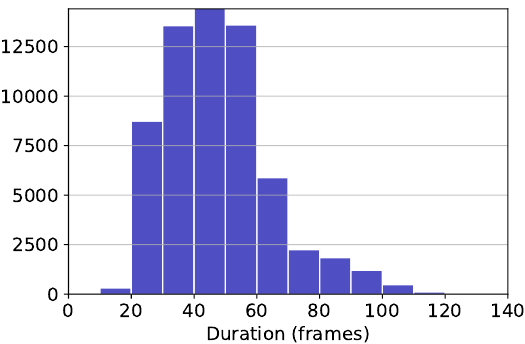
Figure 5. Distribution of syllable duration in Isarn speech corpus. Table 6. Objective results of the training of the proposed model with different values of K